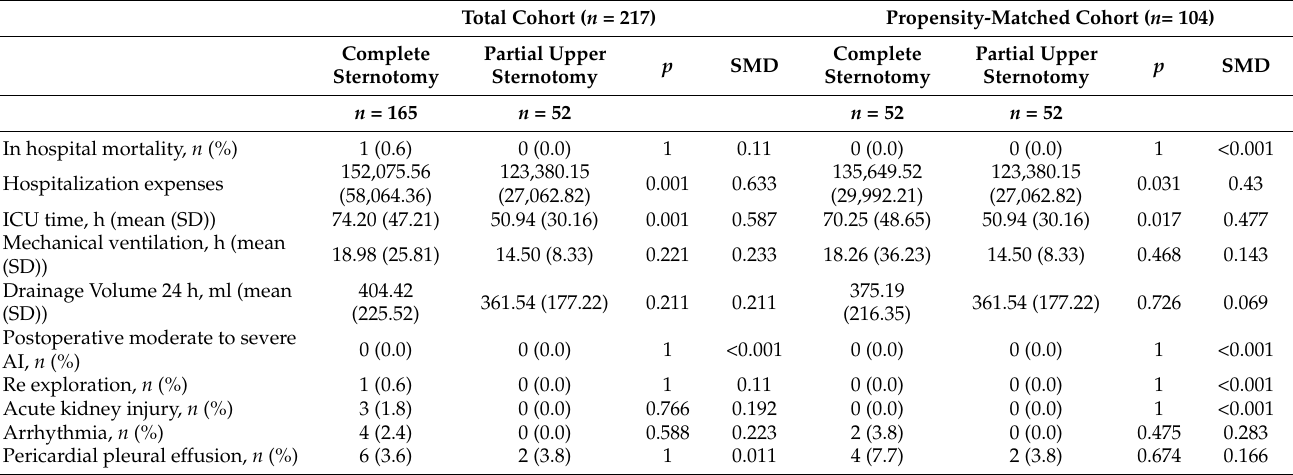
Table 3. Postoperative mortality, morbidity, and hospitalization expenses of the total cohort and propensity-matched cohort.